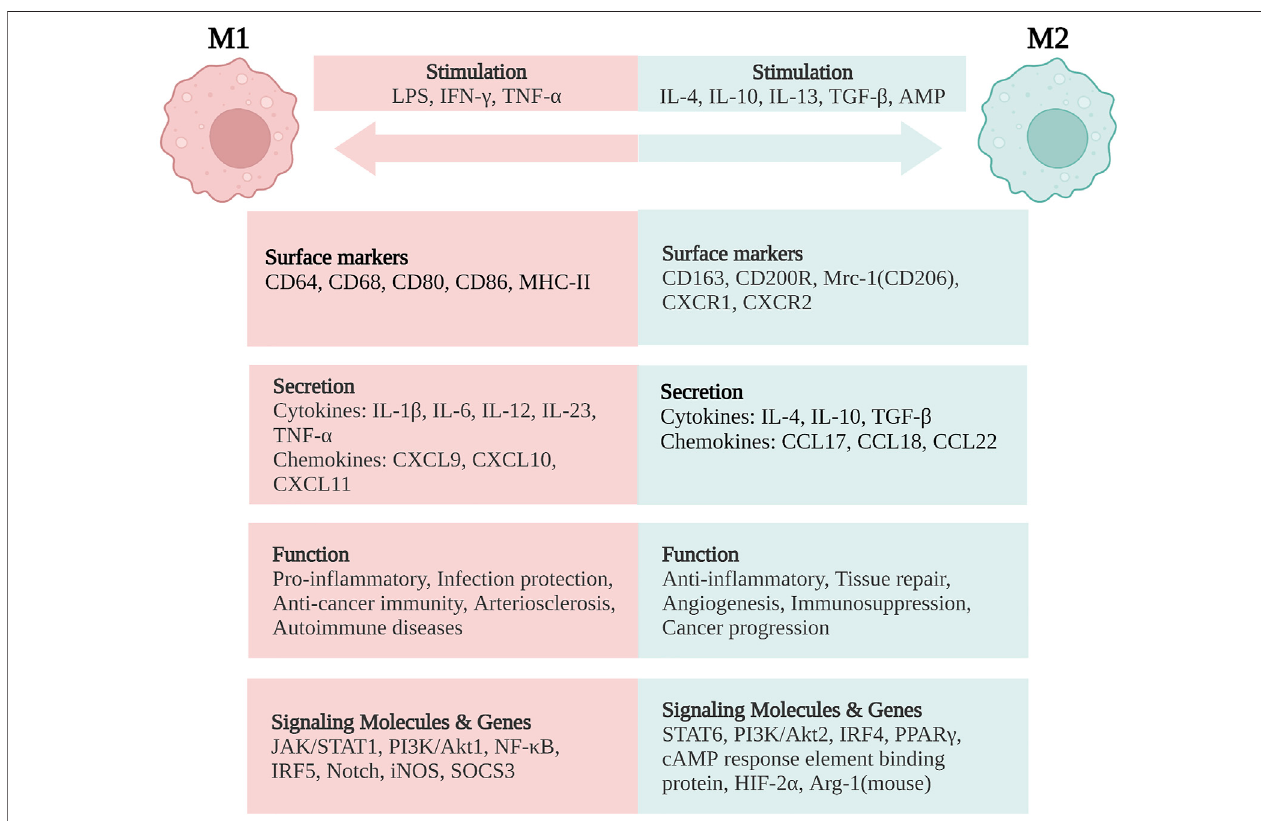
FIGURE2| Macrophagepolarizationand phenotypes. M1 macrophages arestimulated byLPS, IFN- γ ,and TNF- α ,while M2macrophages arestimulated byIL-4, IL-10,IL-13,TGF- β ,andAMP.M1macrophagesarecharacterizedbythefunctionsofpro-in fl ammatory,infectionprotection,anti-cancerimmunity,arteriosclerosis,and autoimmune diseases. M2 macrophages exert the functions of anti-in fl ammatory, tissue repair, angiogenesis, and immunosuppression, but are related with cancer progression. LPS, lipopolysaccharide; IFN, interferon; TNF, tumor necrosis factor; IL, interleukin; TGF, transforming growth factor; AMP, adenosine monophosphate; CD, cluster of differentiation; MHC, major histocompatibility complex; Mrc-1, mannose receptor C-type 1 (also known as CD206); CXCR, CXC chemokine receptor; CXCL, CXC chemokine ligand; CCL, CC chemokine ligand; JAK/STAT, Janus kinase/signal transducer and activator of transcription; PI3K/Akt, phosphatidylinositol-3-kinase/Akt; NF- κ B, nuclear factor- κ B; IRF, interferon regulatory factor; iNOS, inducible nitric oxide synthase; SOCS3, suppressor of cytokine signaling-3; PPAR γ , peroxisome proliferator activated receptor- γ ; HIF-2 α , hypoxia-inducible factor-2 α ; Arg-1, arginase-1. Created with BioRender.com.